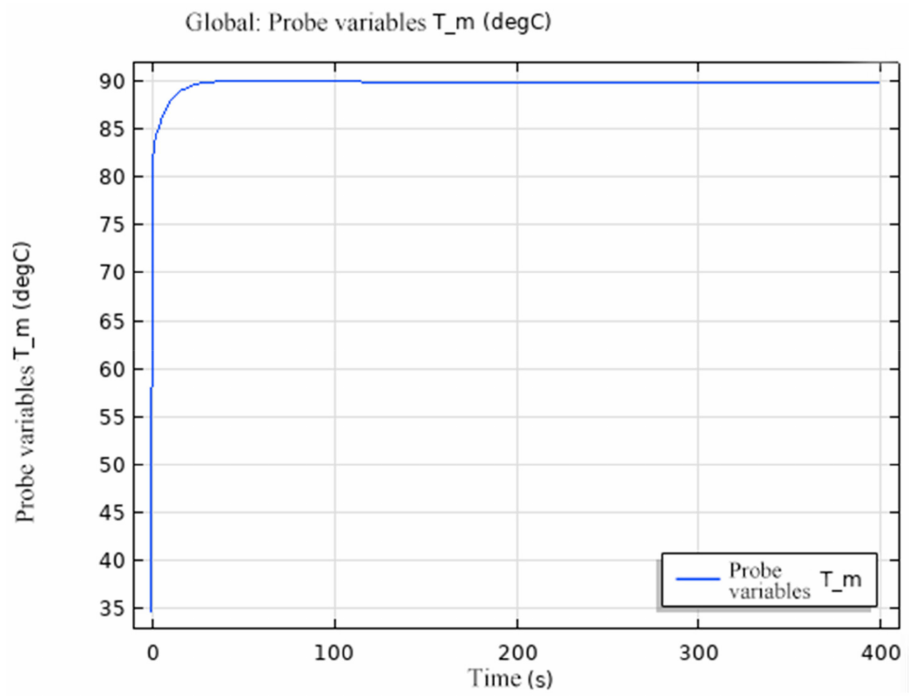
Figure 3. Temperature diagram of domain point probe after